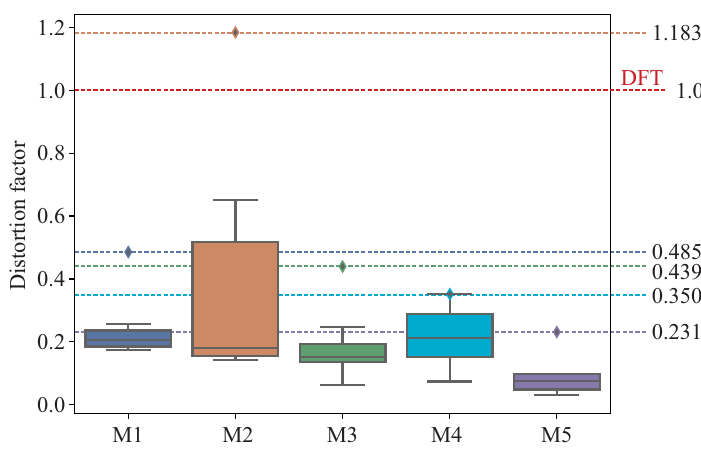
Figure 13. Distortion factor of 5 rearview mirrors using the